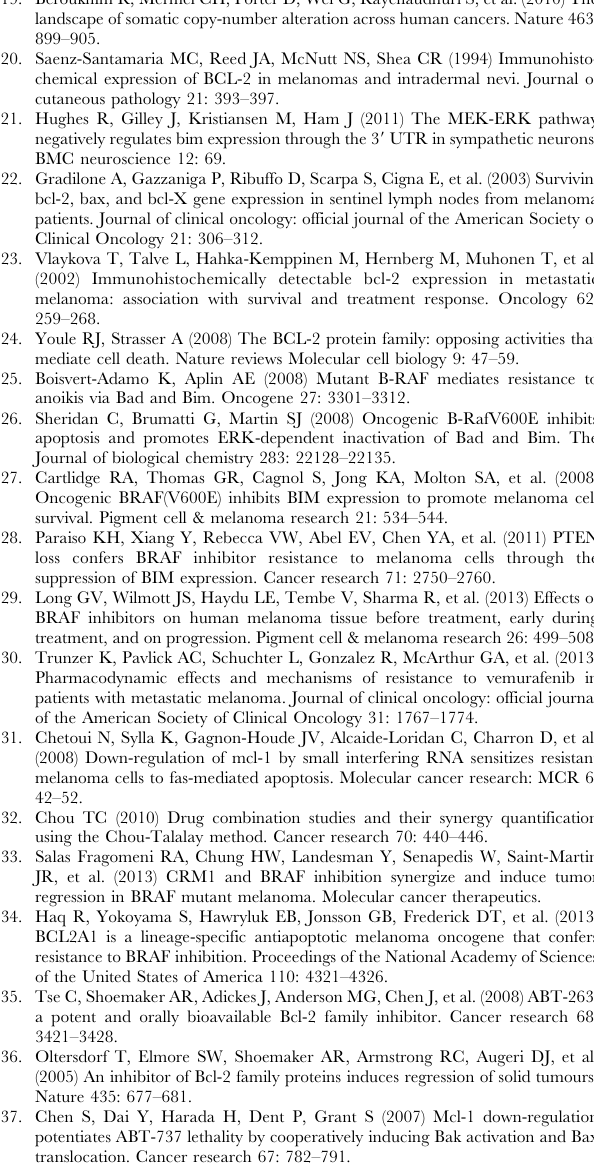
Table S2 PCR Primers. Primers used for